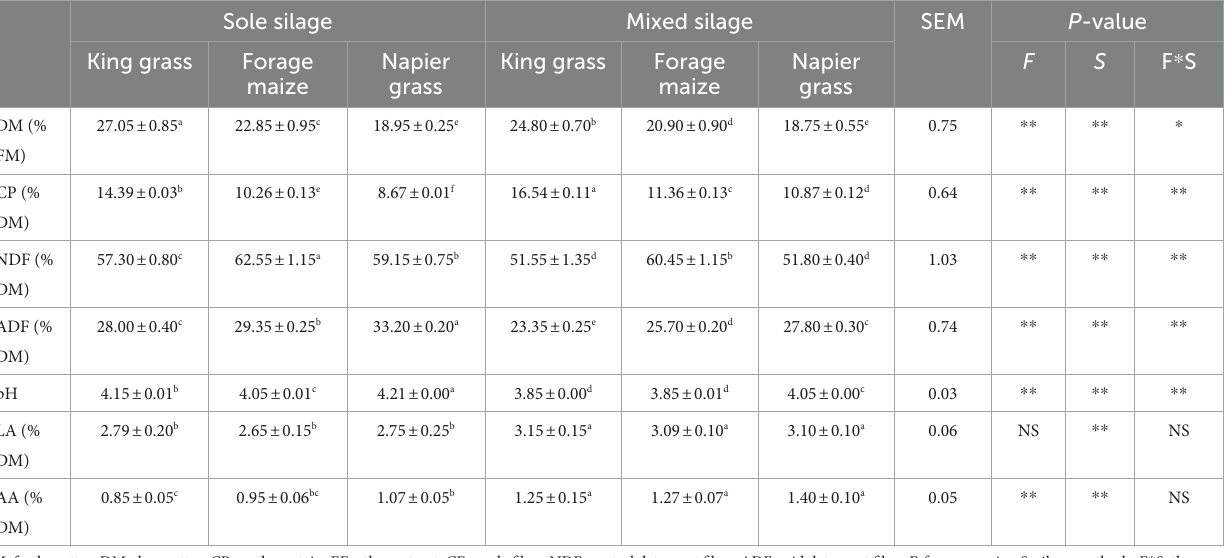
TABLE 2 Chemical composition and fermentation quality after